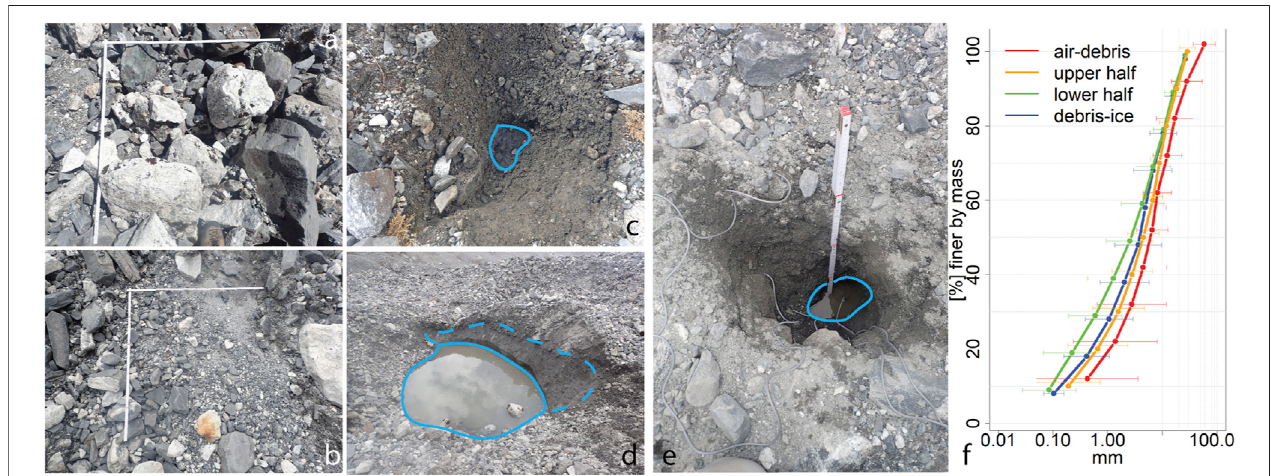
FIGURE 2 | (A) A typically coarse surface with little change between years and likely thick cover underneath, (B) example of short-length-scale transition between cobbles and sand. White ruler shows a 1 by 1 m area. (C) Surface with thin debris cover ( ∼ 0.15 m) consisting of fi ne material, where melt water is surfacing (solid blue line). (D) Glacierice(dashedblueline)appearinginaregionofotherwisethickcover,withmultiplepitsina10 mradiusof > 1 mdepth. (E) Meltwaterpondinginadeeppit ( ∼ 0.65 m). (F) Grain size distribution ofthe debris pack, withsamplesfrom the debris surface, inside the debrispack (upper and lower half) and from just above the ice plotted